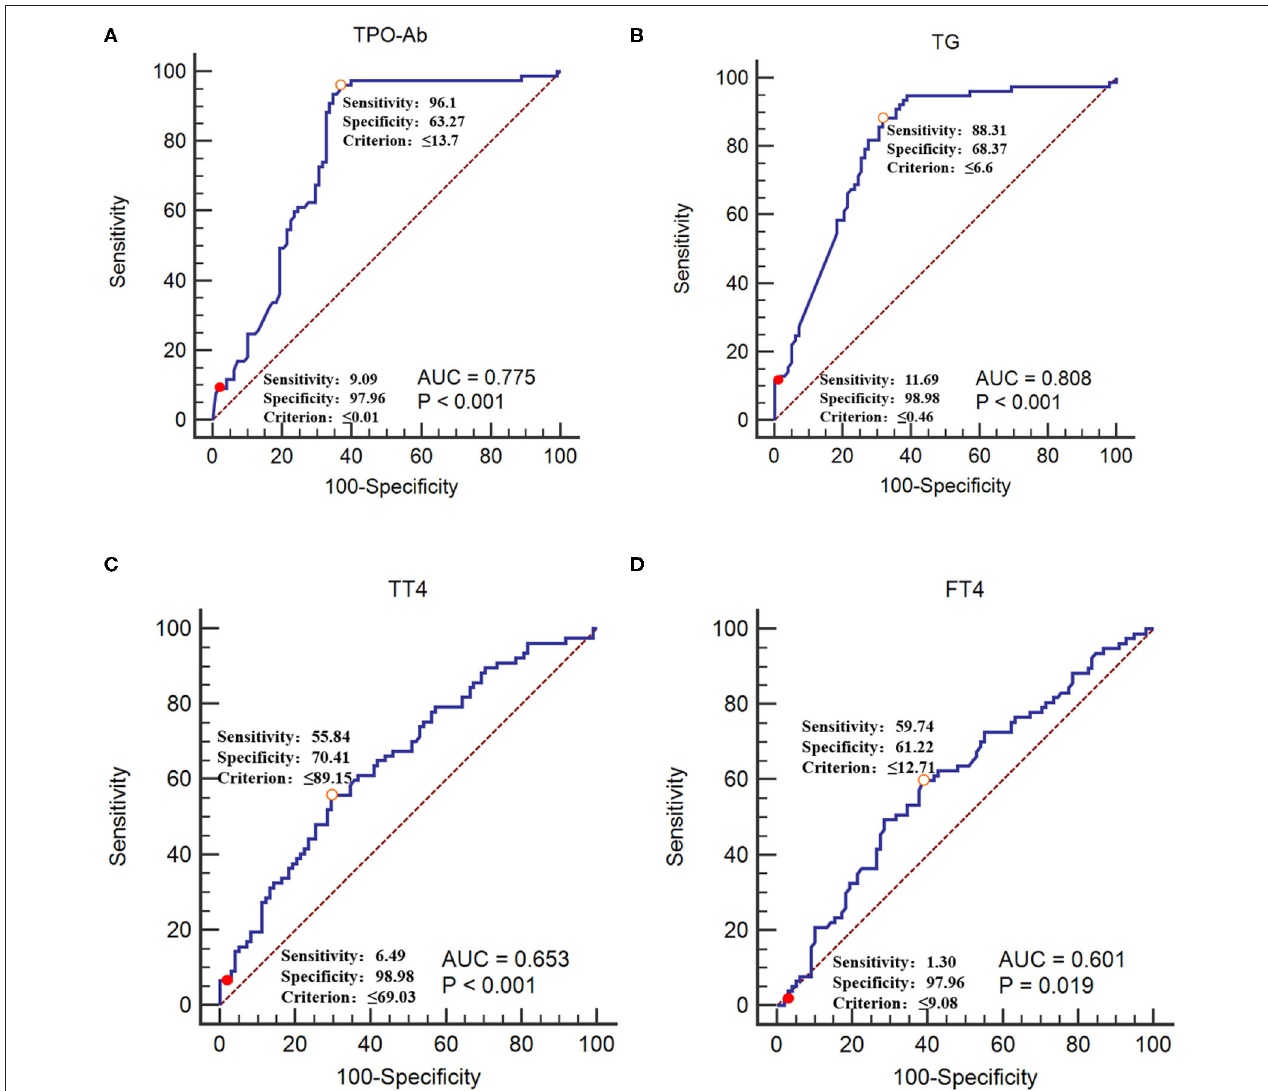
FIGURE 4 | Receiver operating characteristic curves of TPO-Ab, TG-Ab, TT4, and FT4 for CIDP occurrence (A) TPO-Ab, (B) TG-Ab, (C) TT4, and (D) FT4. The GBS group was used as the reference group, and the CIDP group was used as the measurement group. The diagnostic cut-off value corresponds to the maximum point of the Youden index. The diagnostic cut-off value corresponds to the maximal